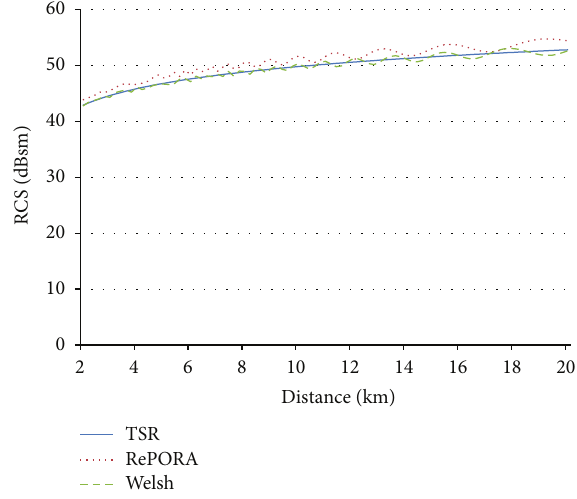
Figure 12: Comparison of the proposed method (in blue), RePORA model (red dotted line), and Welsh’s theoretical expression (green dotted line) in near field for an incidence 𝜃 𝑛 at 9.945 GHz for turbine model